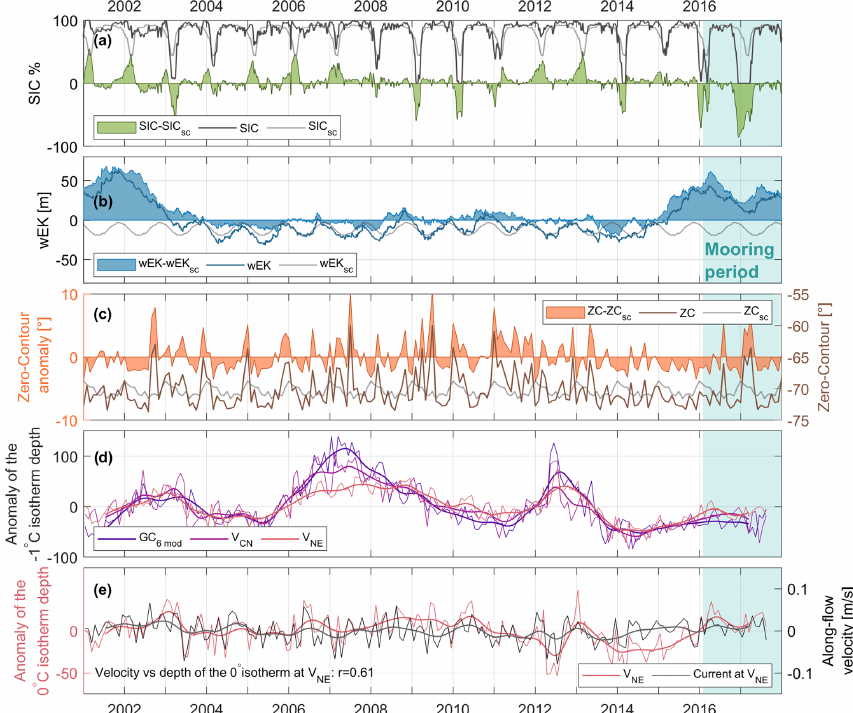
Figure 7. Time-series of de-seasoned (a) SIC at GC 6 (filled green), (b) cumulative Ekman pumping anomaly, wEK, (ERA 5, filled blue) averaged over the SB box (Fig. 1a), and (c) the estimated monthly mean meridional position of the zero-contour (filled orange). The subscript “SC” denotes the seasonal cycle. Light gray lines in (a) – (c) are the estimated seasonal cycles, and dark gray, dark blue and dark orange in (a) – (c) are the corresponding time-series (not de-seasoned). (d) De-seasoned modeled depth of the − 1 ◦ C isotherms at GC 6_mod (purple), V CN (light purple), and V NE (pink). (e) De-seasoned modeled depth of the 0 ◦ C isotherm (pink) and the along-flow (southeast) velocity at V NE (black). In (c) , (d) thin lines are monthly means and thick lines are 12-month moving averages. In all panels, the time period with mooring measurements is marked by the turquoise